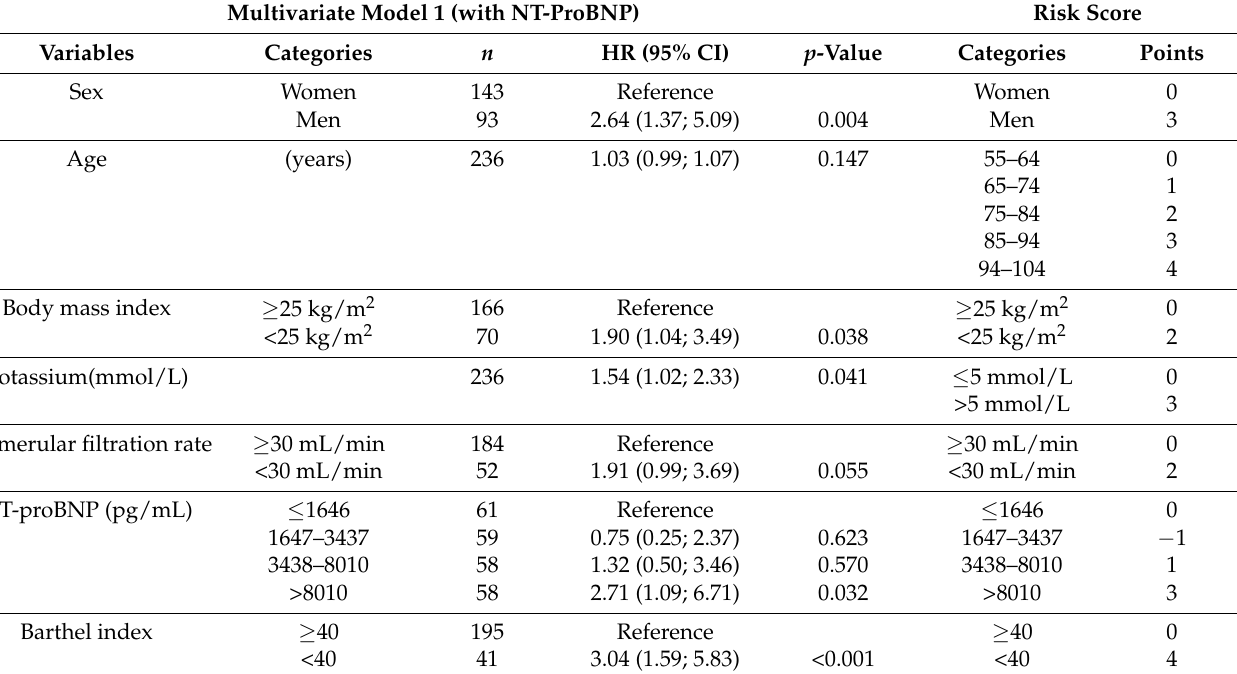
Table 2. Predictive model for three-month mortality in patients with advanced heart failure with